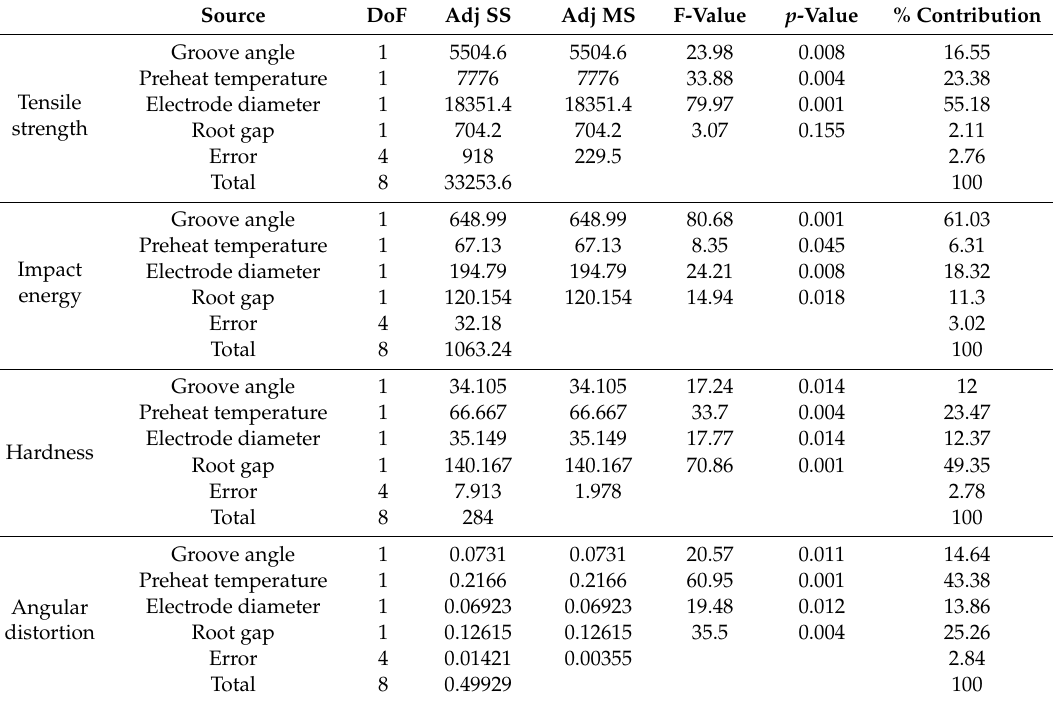
Table 5. ANOVA for individual responses.